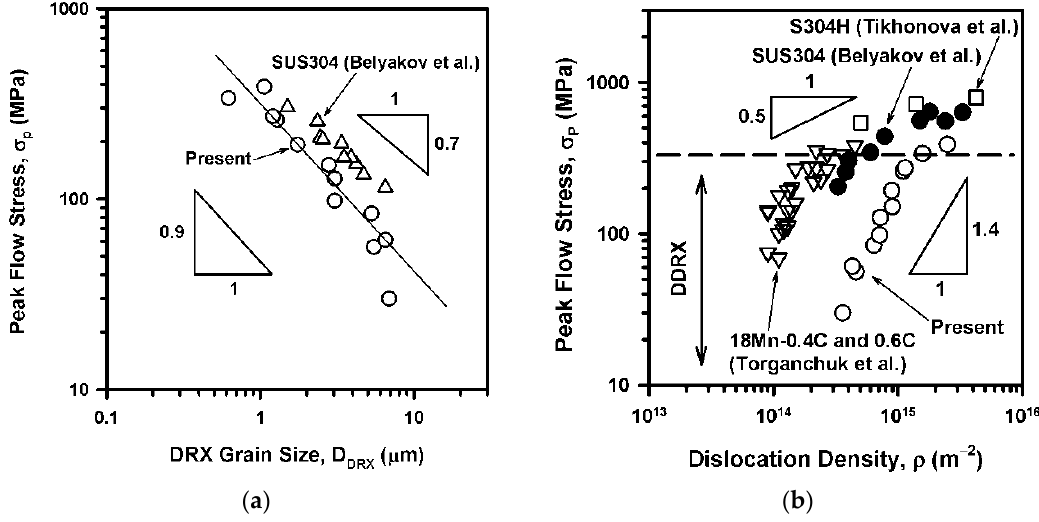
Figure 10. Relationships between the DRX grain size and the peak flow stress ( a ), and the dislocation density and the peak flow stress ( b ) in a highly-alloyed austenitic stainless steel subjected to hot compression. Some available data for austenitic steels [14,17,21] are also indicated for reference.